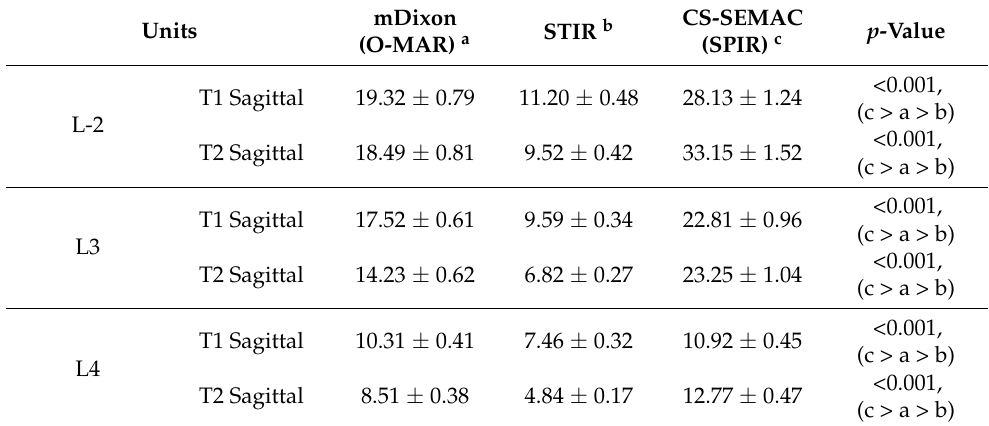
Table 3. SNR result of T1, T2 MAR effect in testing Pig L-spine Phantom.